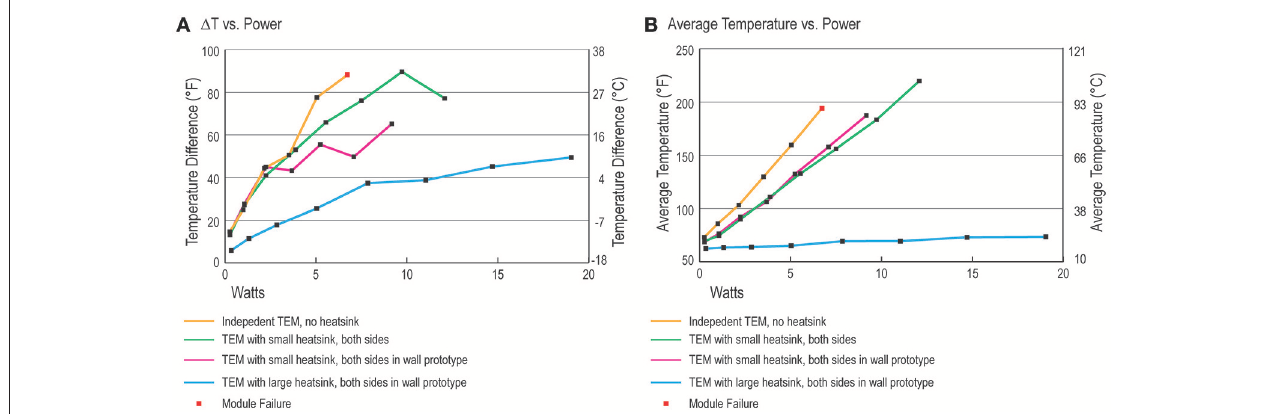
FIGURE 8 | (A) Temperature difference and (B) average temperature results in ambient conditions.